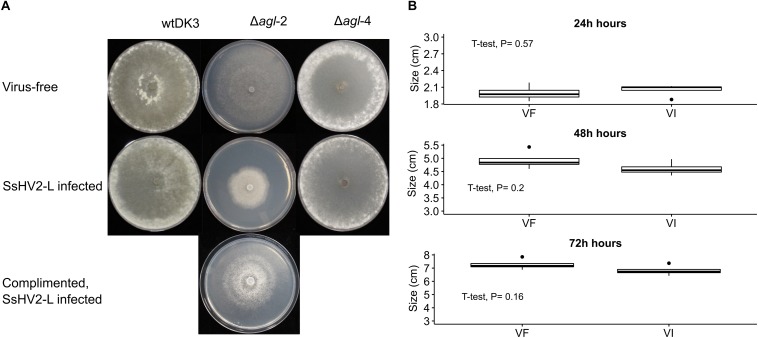
Colony morphology of virus-free and virus-infected gene deletion mutants. (Top row) Virus-free DK3, Δagl-2 and Δagl-4. (Bottom row) wild-type and mutant strains infected with hypovirus SsHV2-L. Cultures were grown for (A) 4 days on PDA. The virus-infected agl-2 mutant displays significantly slower growth and altered colony morphology. (B) Comparison of the complemented strains with and without virus infection (P > 0.05).